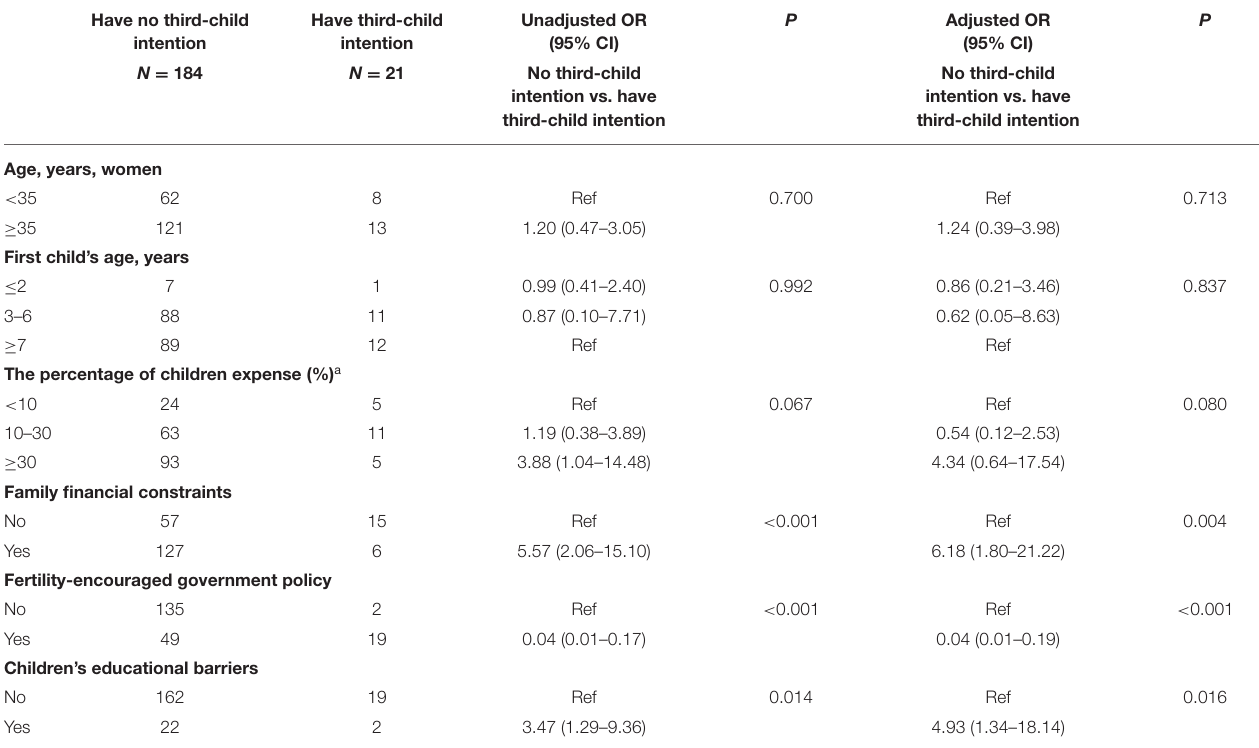
TABLE 4 | Factors associated with third-child intention. Have no third-child intention